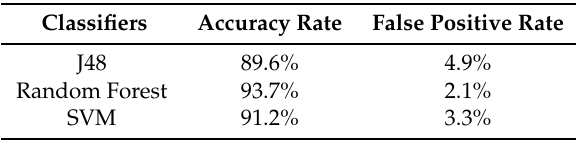
Table 2. Performance of entropy-based